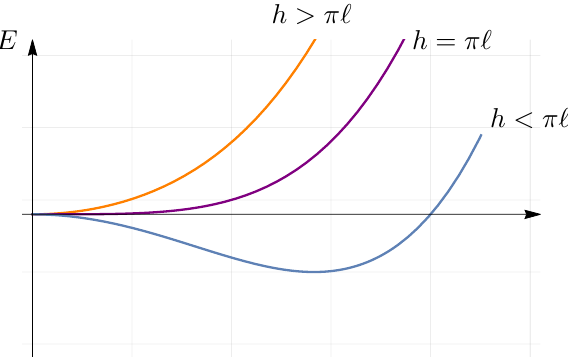
Figure 15 . The potential energy as a function of the configuration space of the web as h is varied, for L ≤ ‘